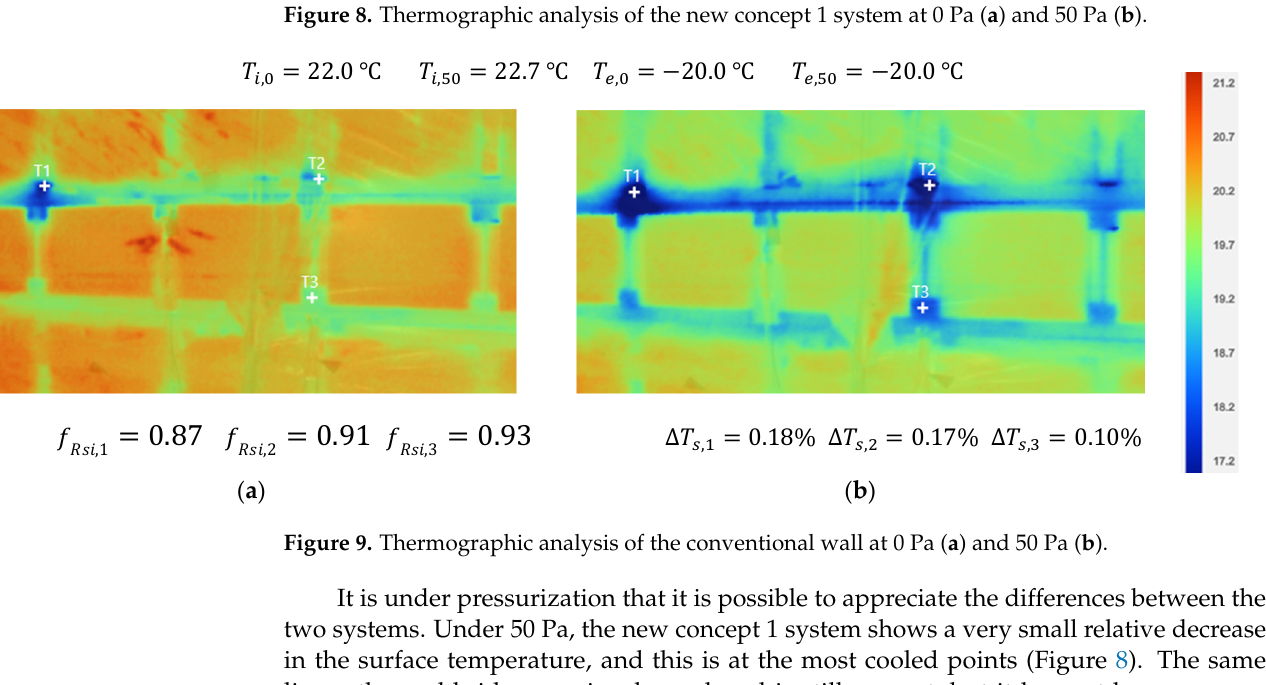
Table 4. Air leakage rate by fan pressurization through House A and House B.